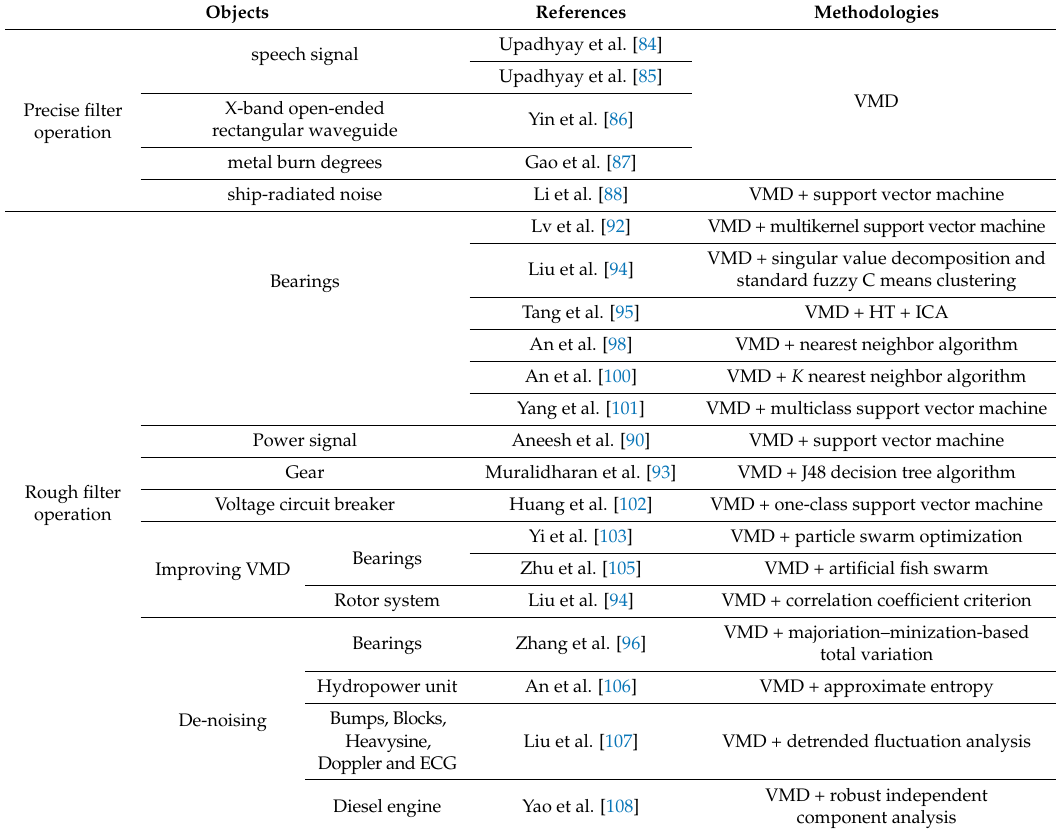
Table 2. Summary of works for